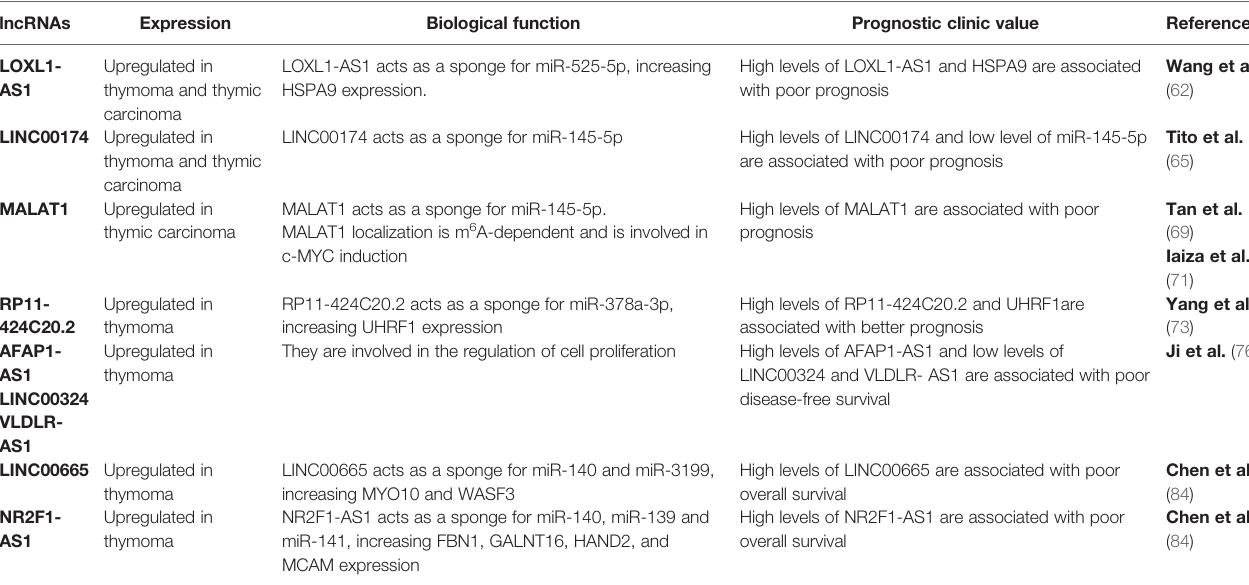
TABLE 1 | LncRNAs deregulated in